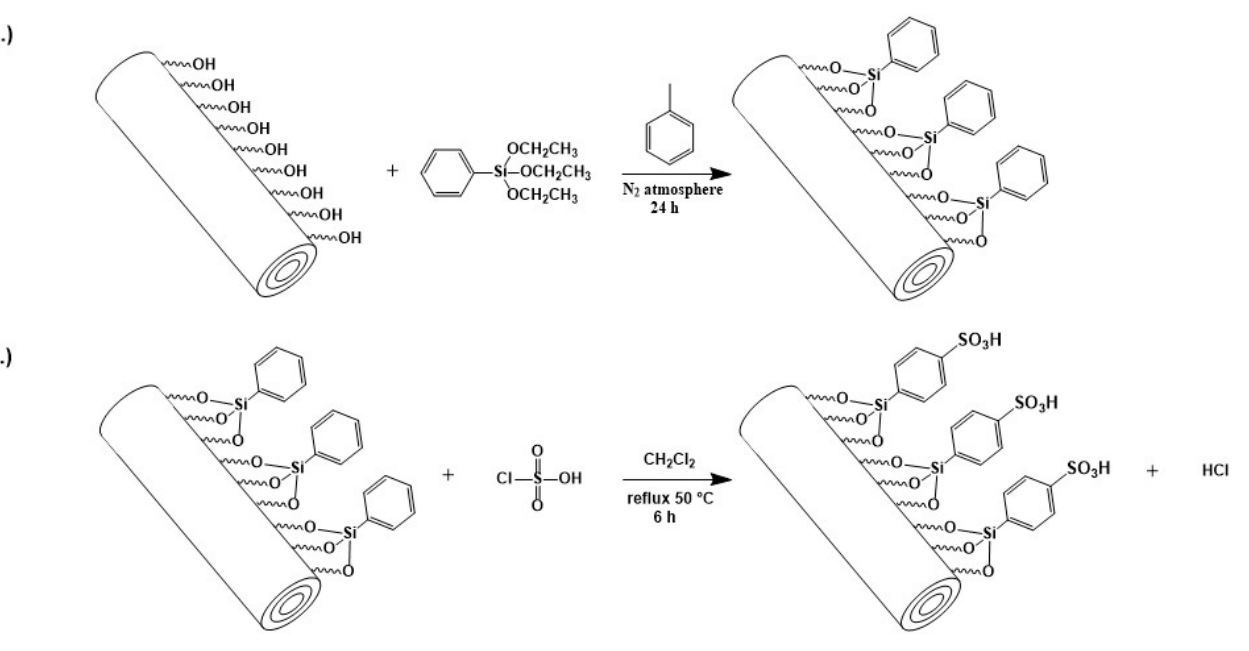
Figure 1. Two-step synthesis of HNT-PhSO 3 H consisting of organosilylation ( 1 .) and sulfonation step ( 2 .) according to Silva et al. and Peixoto et al. [16,17].